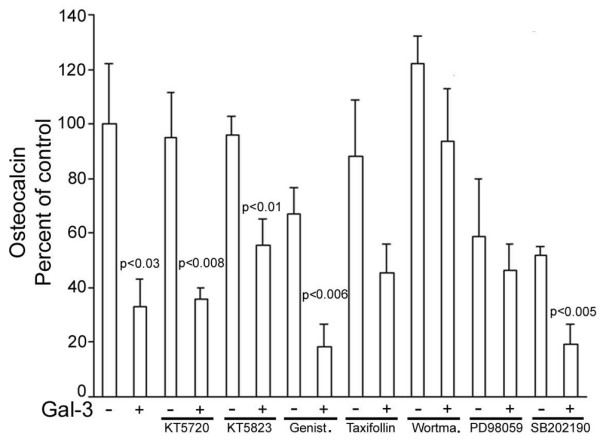
Signalling pathways of inhibition by galectin-3 (gal-3) of vitamin D3-stimulated osteocalcin production. Osteoblasts were treated with 5 μg/ml of recombinant human gal-3 in the presence of vitamin D3 and osteocalcin was determined. Inhibitor concentrations were: KT5720, 2 μM; KT5823, 2 μM; Genistein (Genist.), 1 μM; Taxifollin, 1 μM; wortmannin (Wortma.), 250 nM; PD98059, 10 μM; and SB202190, 2 μM. *P versus the autologous control; n = 5.